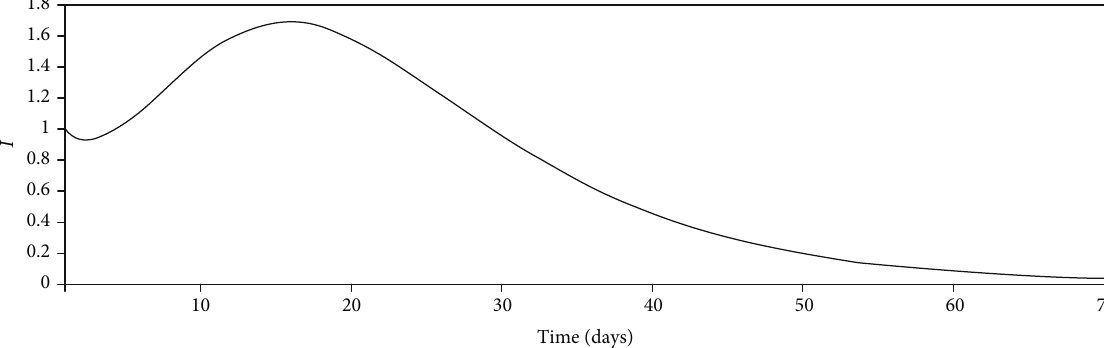
Figure 10: Estimated infected population in a household (assuming the average number of persons in a Sri Lankan household to be 5).